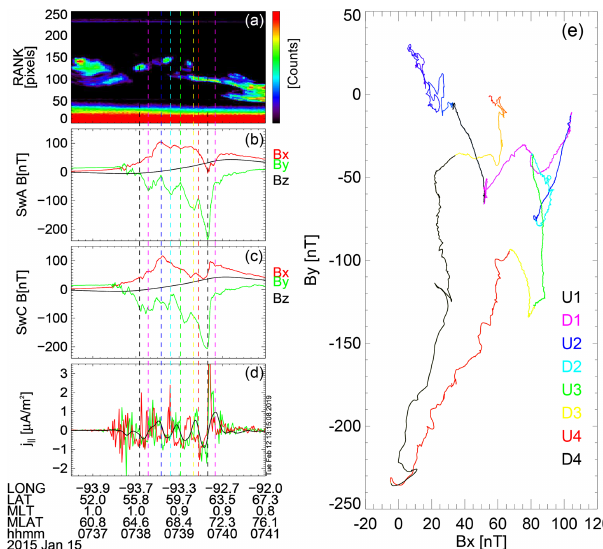
Figure 8. Same panels as in Fig. 4. We note that some of the delim- ited FACs also have an internal structure, e.g., first magenta interval labeled